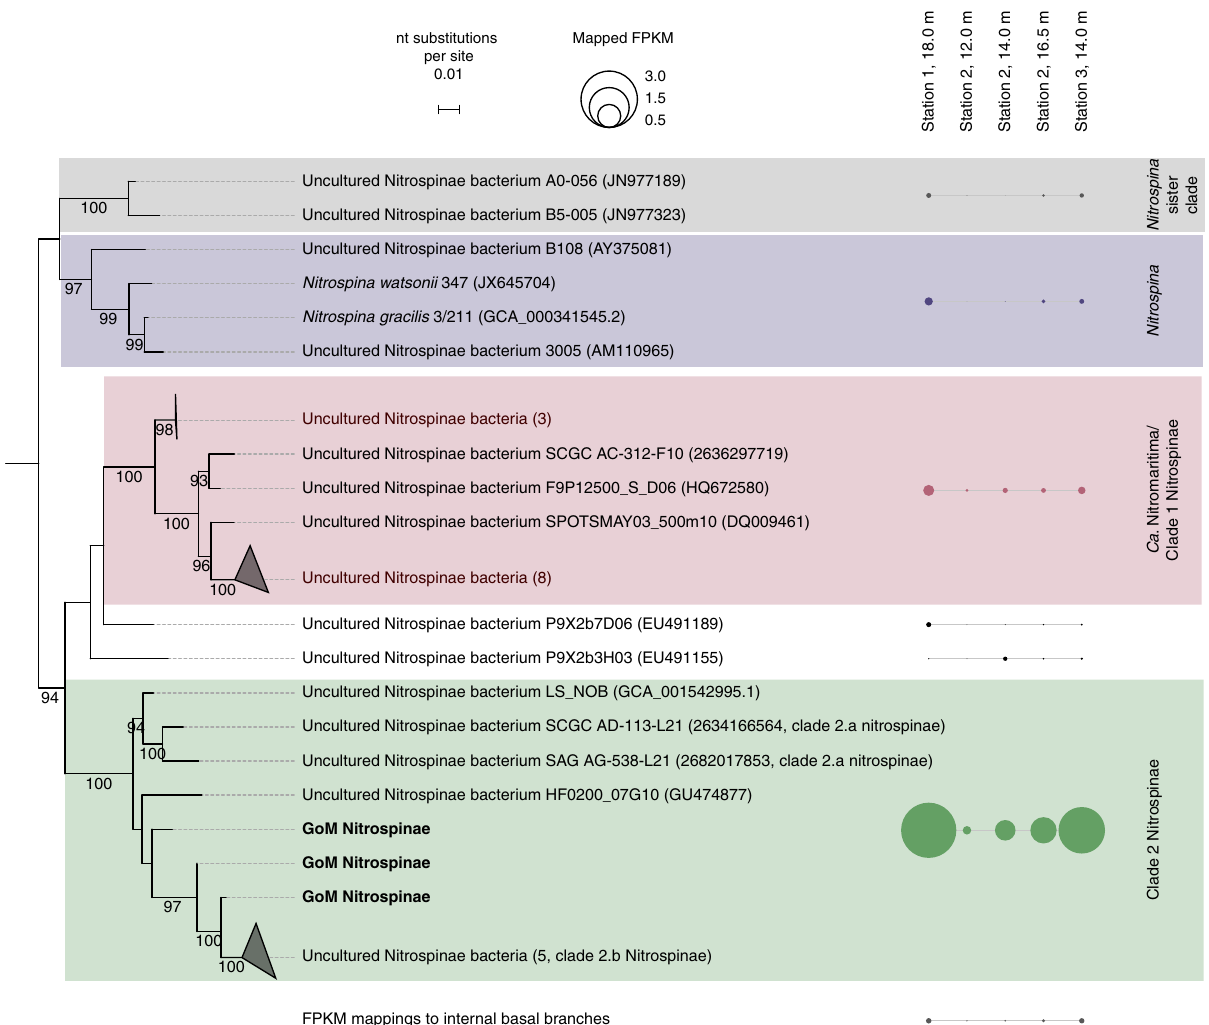
Fig. 3 A maximum likelihood reconstruction of Nitrospinae 16S rRNA gene phylogeny. Nitrospinae 16S rRNA gene sequences retrieved from GoM metagenomes are indicated as “ GoM Nitrospinae ” and printed in bold Outgroup sequences represent cultured Deltaproteobacteria. GoM metagenomic read fragments (FPKM) were mapped onto the alignment and are shown next to the respective clades as circles. FPKM mapping to internal basal nodes were grouped and are displayed separately. The scale bar represents estimated nucleotide substitutions per site, and bootstrap values >90% are